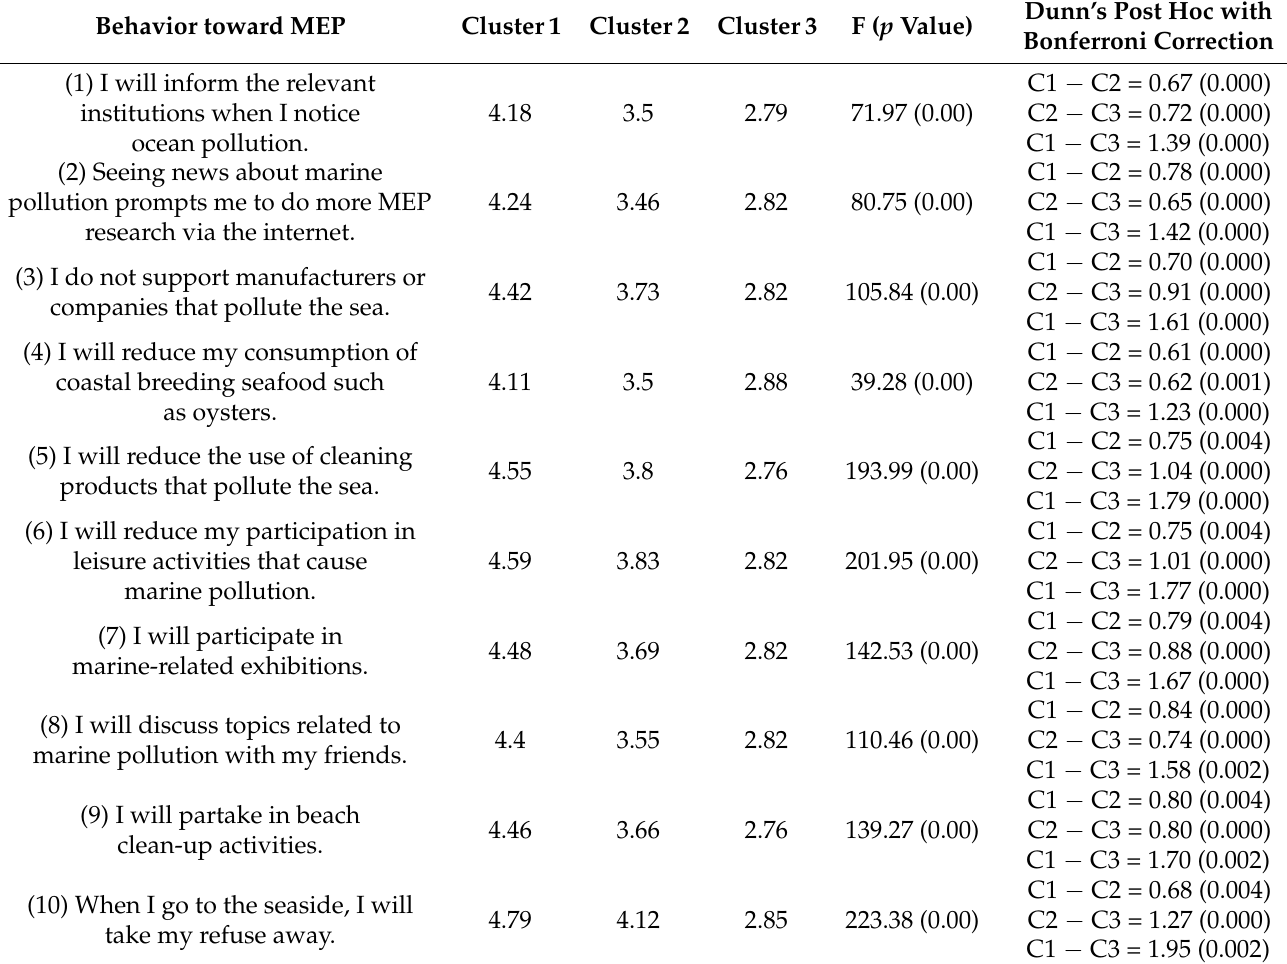
Table 5. Attitudes toward marine environment pollution (MEP) and related behavioral